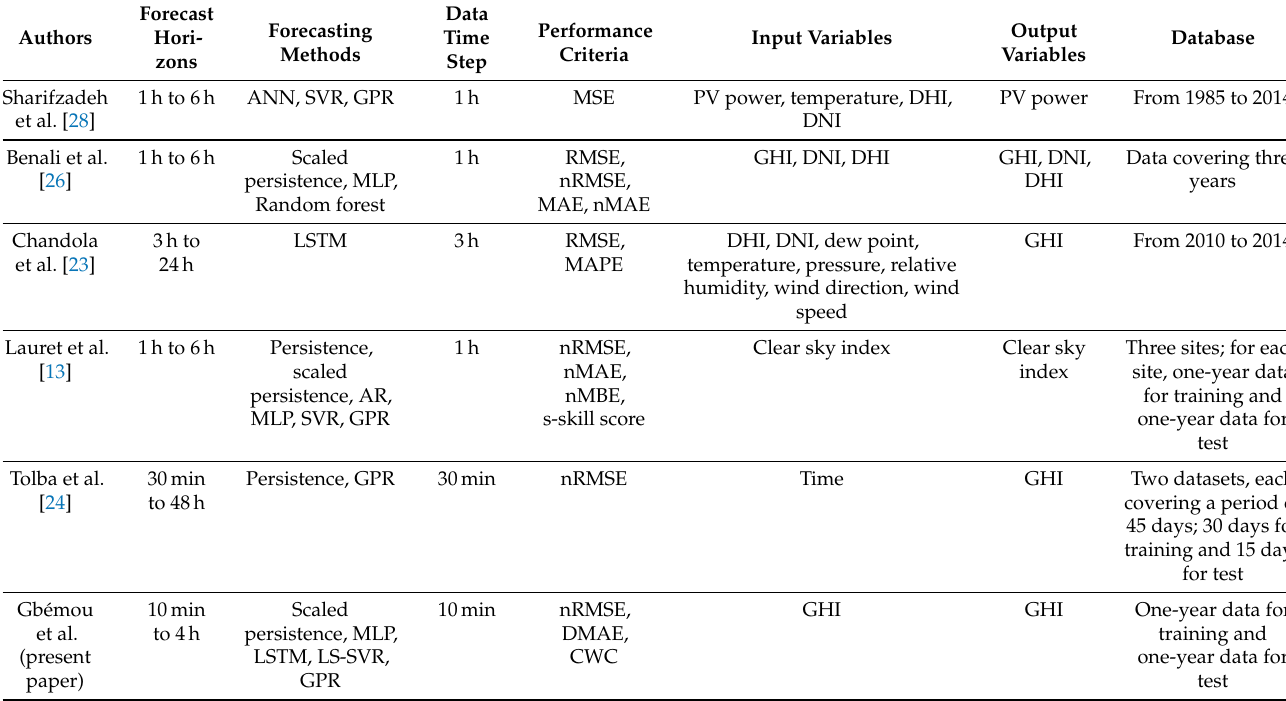
Table 1. Main recent comparative studies using machine learning methods. For the meaning of abbreviations, see at the end of the